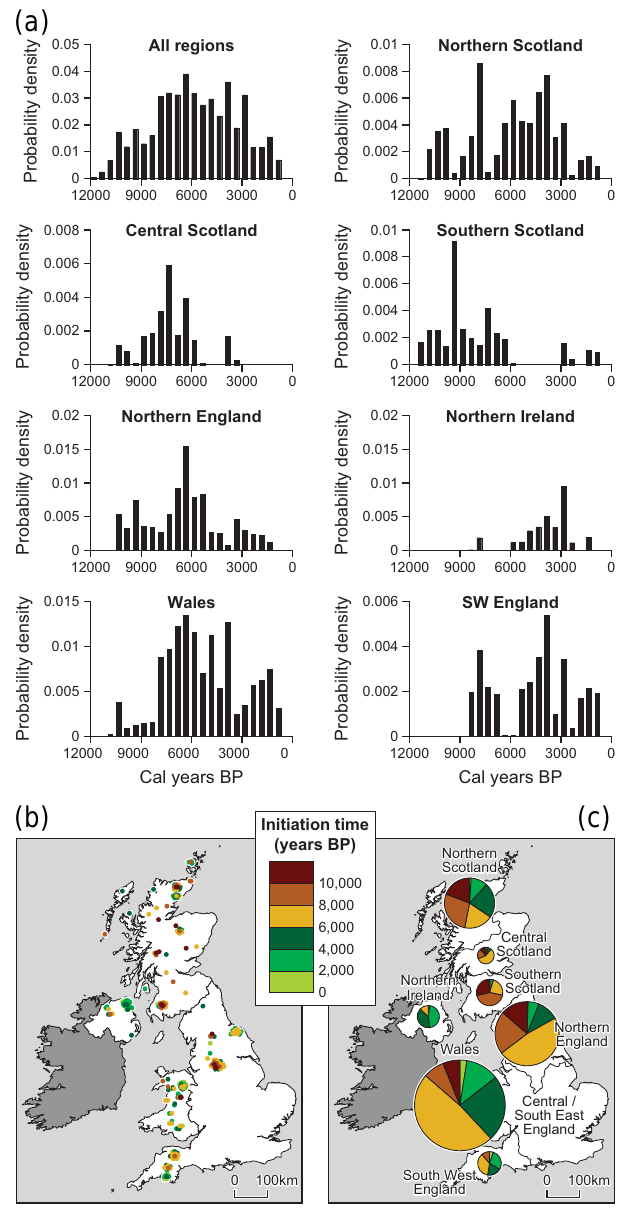
Figure 4. Assembled basal calibrated radiocarbon dates from blan- ket bogs over Great Britain and Ireland: (a) regional graphs of ini- tiation dates through time binned every 500 years; (b) map of indi- vidual initiation dates; and (c) map of initiation dates summarized per region.